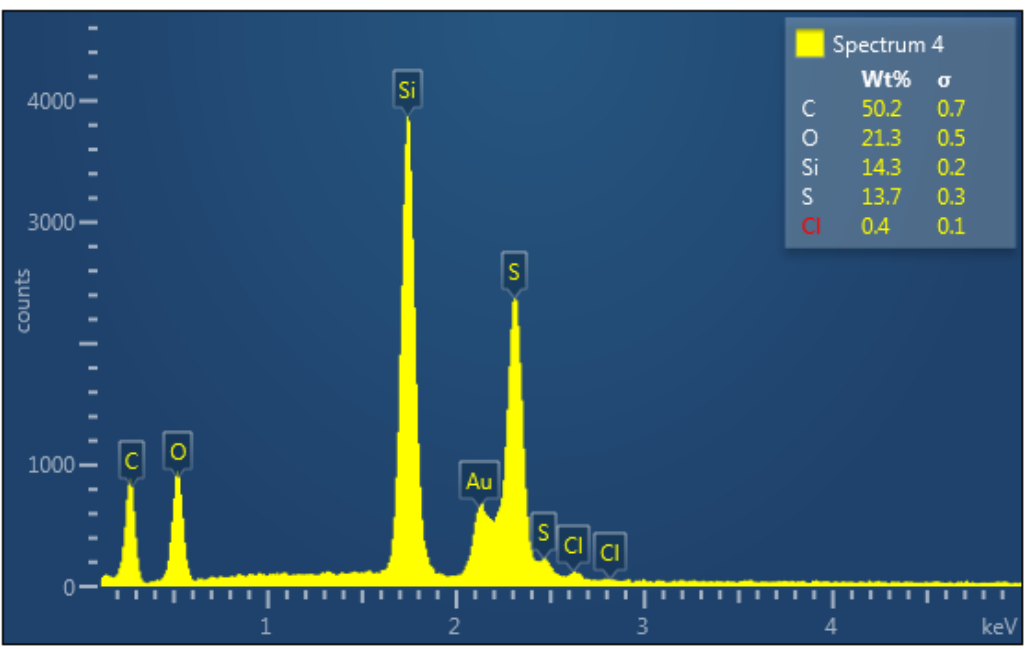
Figure 9. Field emission scanning electron microscopy (FESEM) images of adsorbent 2 before adsorption.